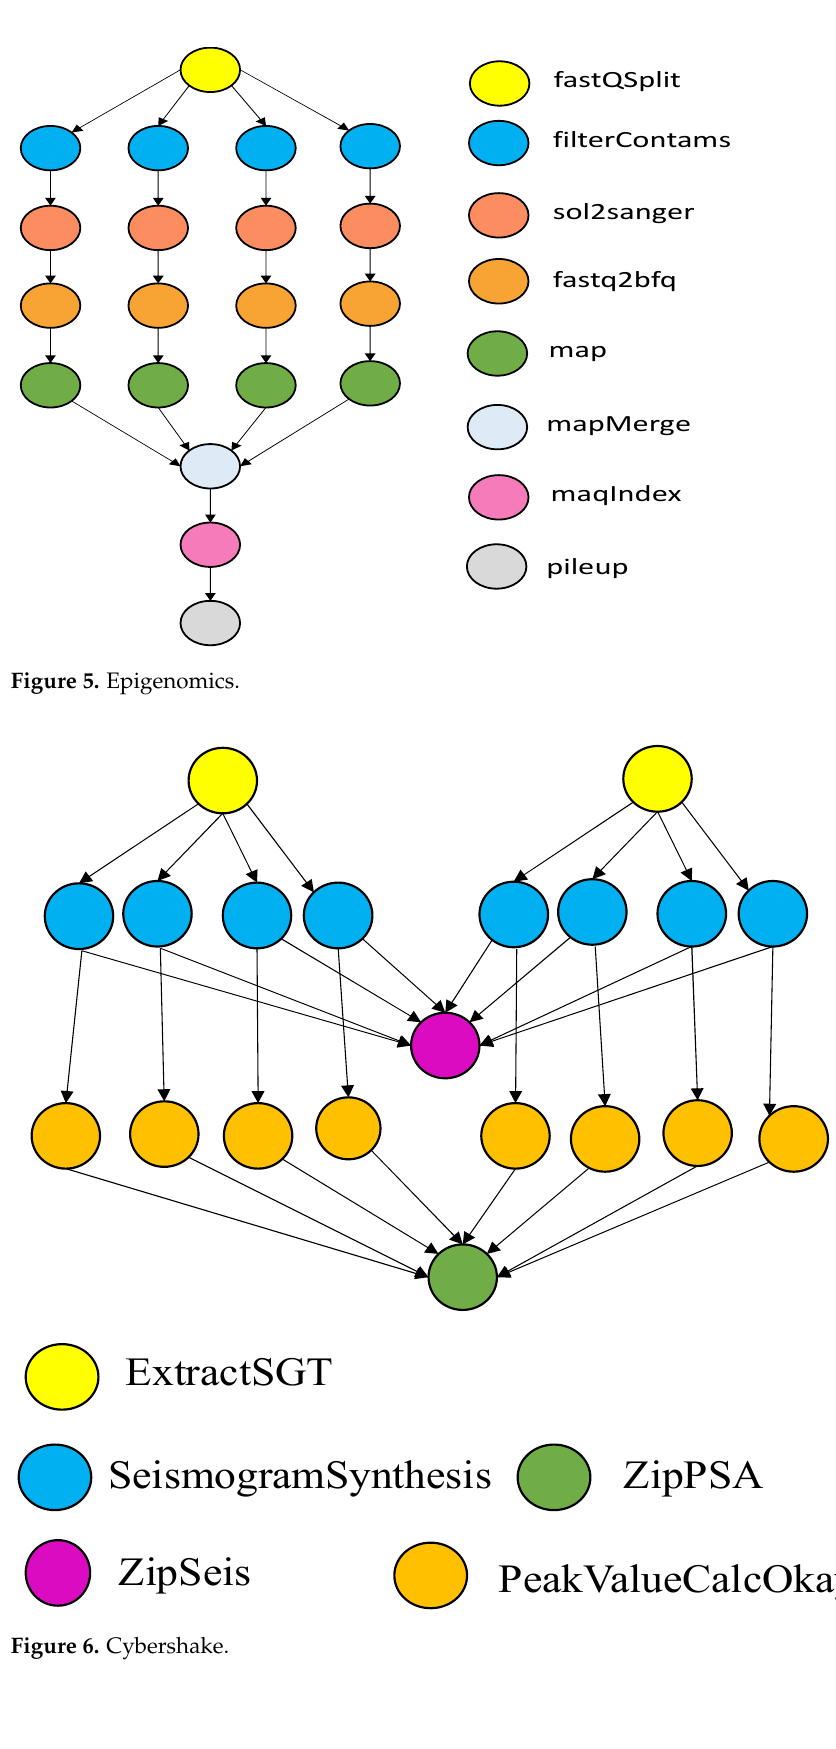
Figure 6. Figure 6. Cybershake.